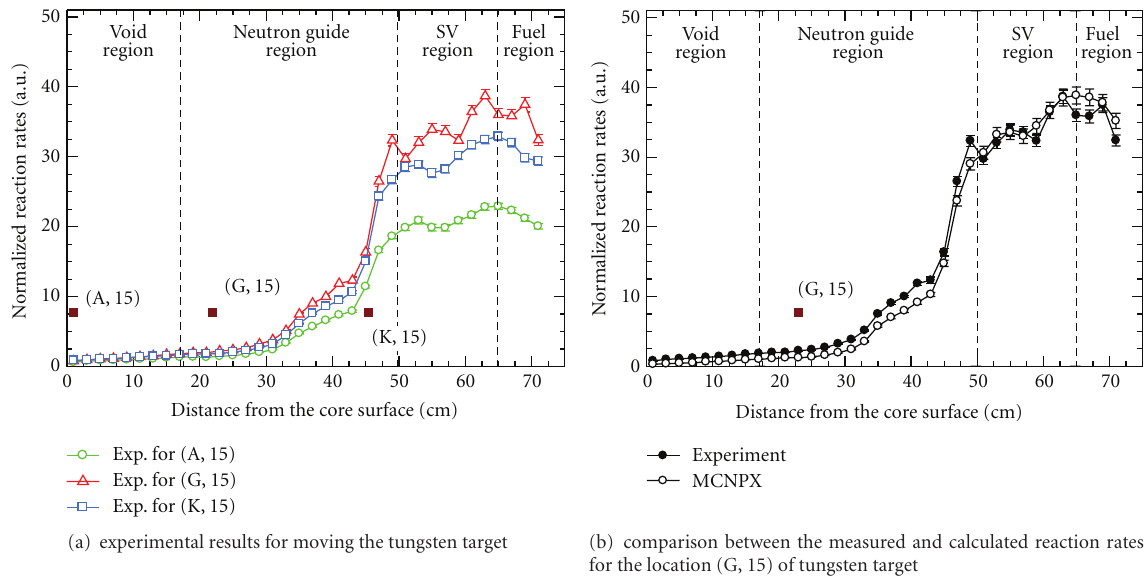
(a) experimental results for moving the tungsten target (b) comparison between the measured and calculated reaction rates for the location (G, 15) of tungsten target Figure 6: Reaction rates of 115 In( n , γ ) 116m In reactions along the region (13-14, A–P; Figure 2) in the ADS experiments.